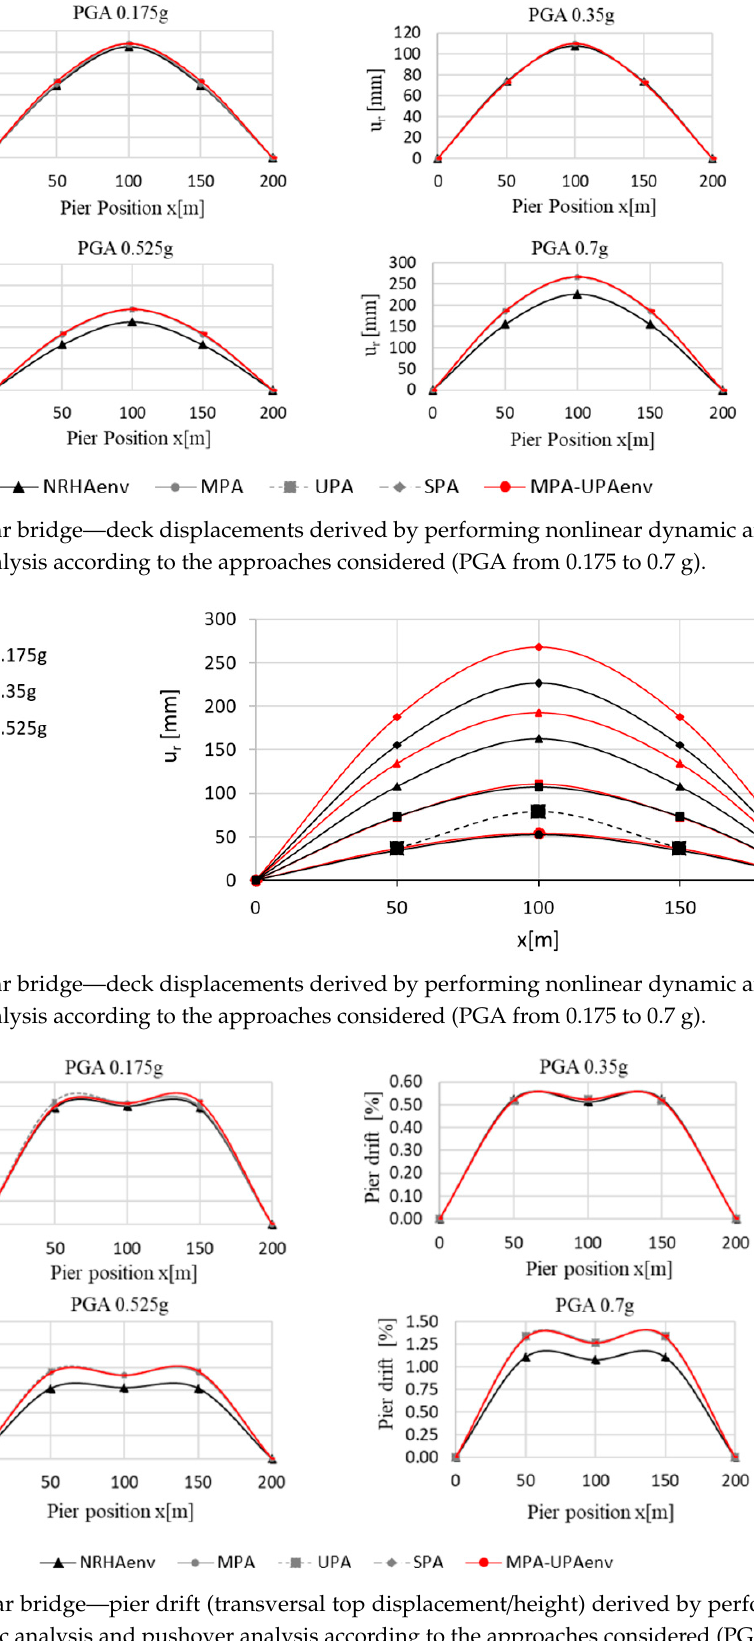
Figure 17. Regular bridge—deck drift (relative displacement between two consecutive joints P i and P i+1 /P i -P i+1 span length) derived by performing nonlinear dynamic analysis and pushover analysis according to the approaches considered (PGA 0.175–0.7 g).